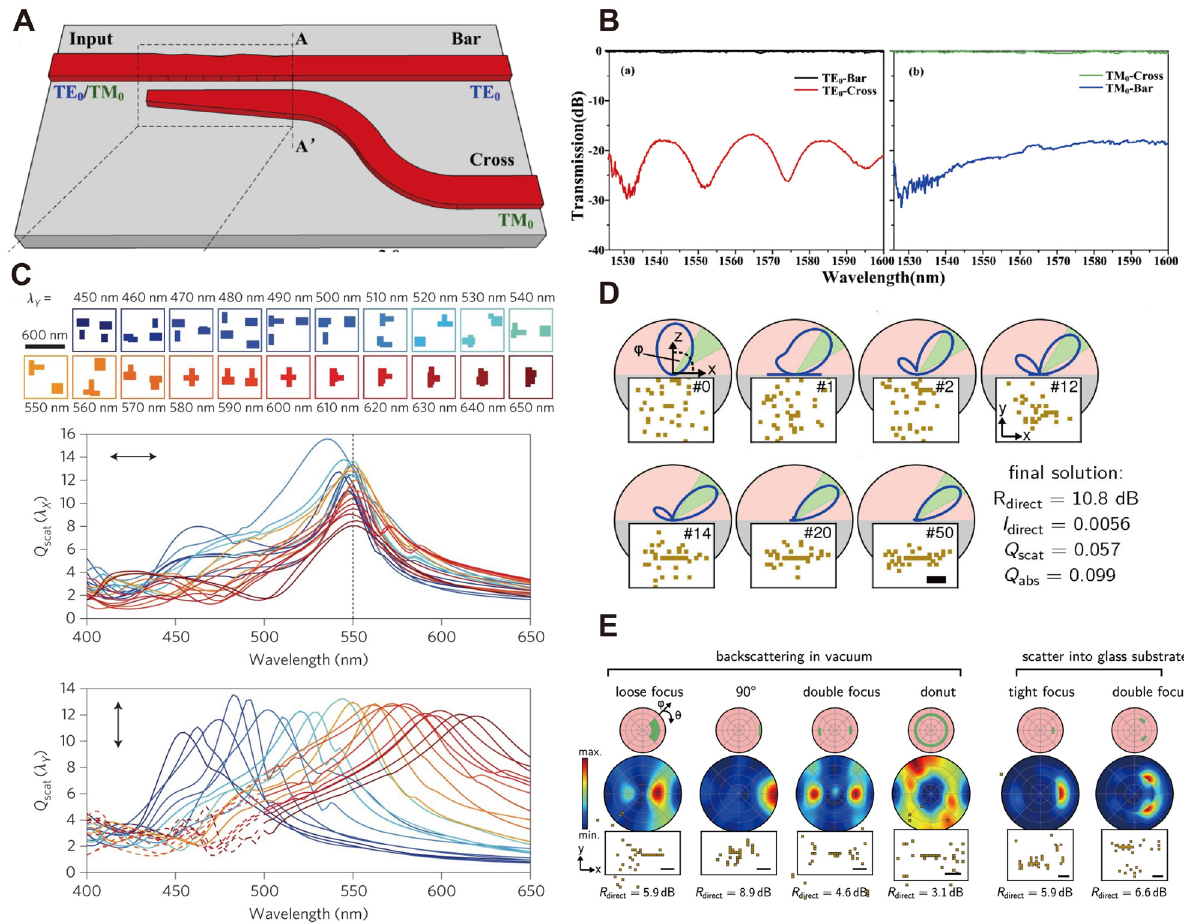
substrate. Bar and 2